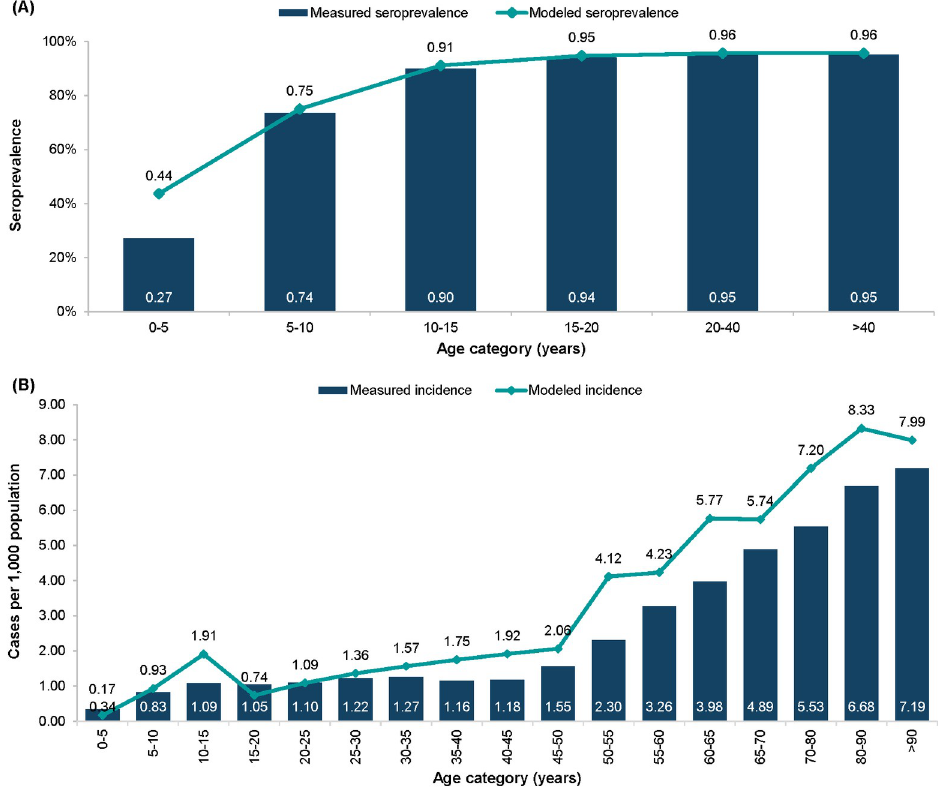
Fig 1. Model fit to (A) varicella seroprevalence and (B) herpes zoster incidence rates in